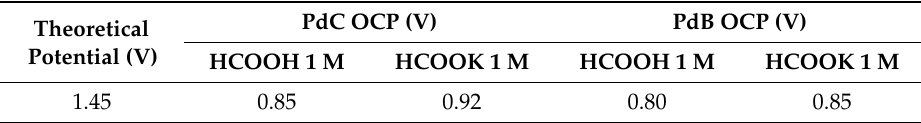
Table 2. Theoretical reaction potential and measured open circuit potentials of the studied cells.